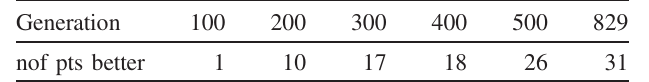
TABLE II. The number of (nof) design points (pts) in a specific generation that satisfy the constraints in Eq. (28) and have all of the objectivefunctionvaluesbetterthanthoseofthemanuallyobtained solution, referred to as the “ design solution. ” This is abbreviated as “ nof pts better. ” Generation 829 is the last one that is considered because the optimization was stopped after 48 h. All of the objective function values are computed with 500 turns in TRACY . Generation